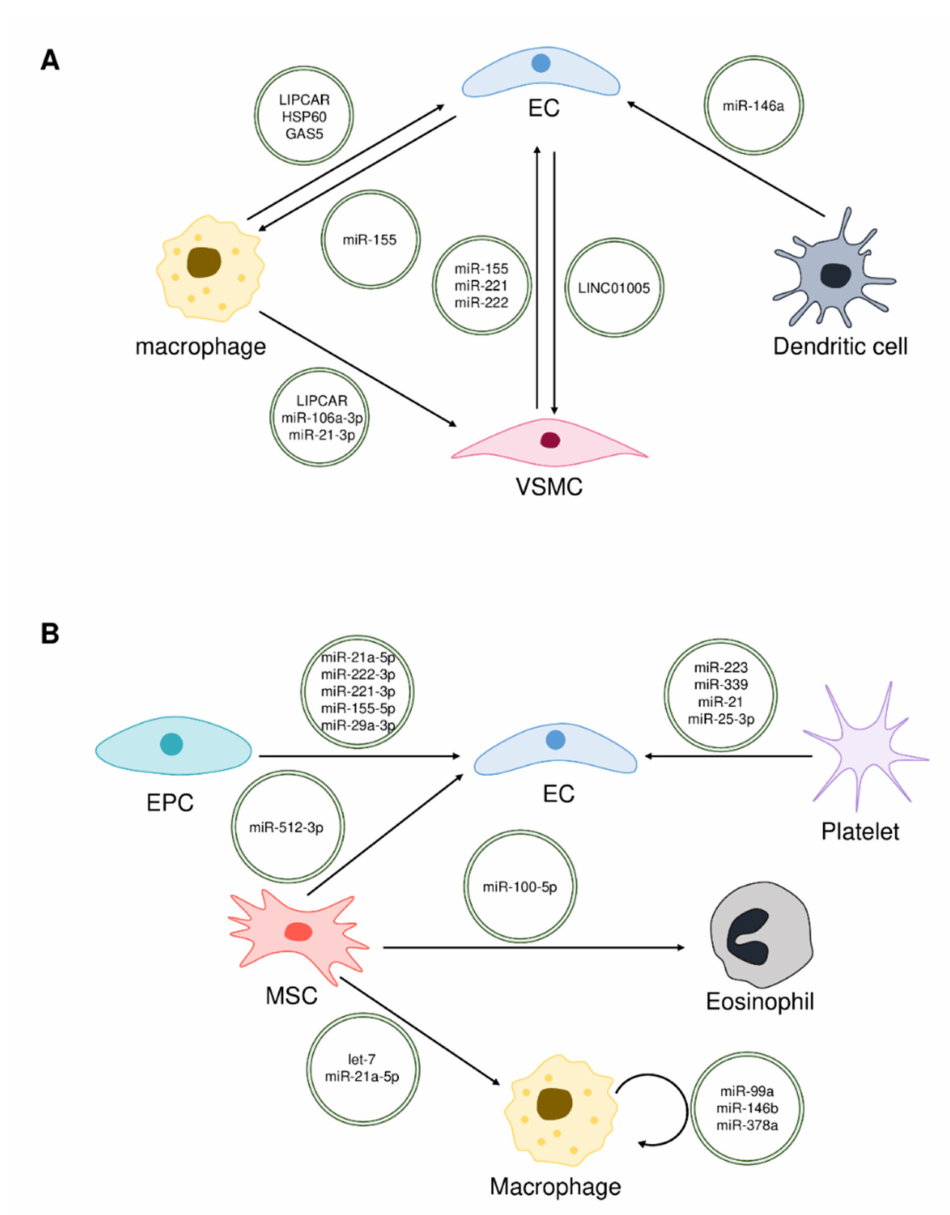
Figure 2. Cargos in exosomes to regulate atherosclerosis. Donor cells communicate with recipient cells via exosomes carrying various cargos, such as non-coding RNAs and proteins. Some exosomes carry cargos that induce atherosclerosis ( A ), while others carry those that inhibit atherosclerosis ( B ). The direction of the arrow indicates the transfer of exosomes from donor cells to recipient